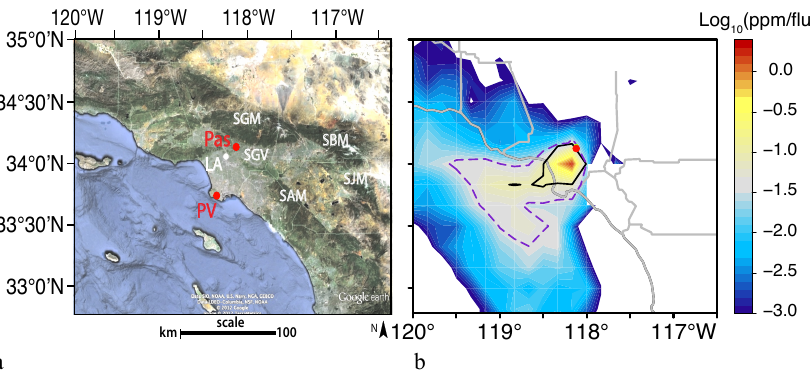
Fig. 1. (a) Google Earth map showing the location of Pasadena (Pas) in southern California. The sampling location was 34.14 ◦ N, 118.12 ◦ W, 246 m a.s.l.; the sampling height was 10 m above ground level. Also shown is the site on Palos Verdes Peninsula (PV) where CO 2 was measured for background air (see Appendix B1). Geographic features are indicated: LA – downtown Los Angeles; SGV – San Gabriel Valley; SGM – San Gabriel Mountains; SBM – San Bernardino Mountains; SJM – San Jacinto Mountains; SAM – Santa Ana Mountains. (b) Average midday footprint for the Caltech campus for 13:00 LT during the CalNex-LA campaign (see Appendix B3 for a description of the calculation). The color scale indicates the influence of different locations on the CO 2 measured in Pasadena, inppm CO 2 in Pasadena/flux (flux in µmoles − 1 m − 2 ) at the indicated location. Gray lines indicate county boundaries. The dashed purple contour surrounds the area that contributes 70% of the surface influence on the air sampled at the Caltech site; the solid black contour indicates the region contributing 50% of the surface influence. The shape of this contour reflects the average midday wind direction, from the SW (Fig. 3c). The air sampled in Pasadena comes predominantly from the ocean, adding emissions from the LA basin as it passes over, making Pasadena a good receptor site for the